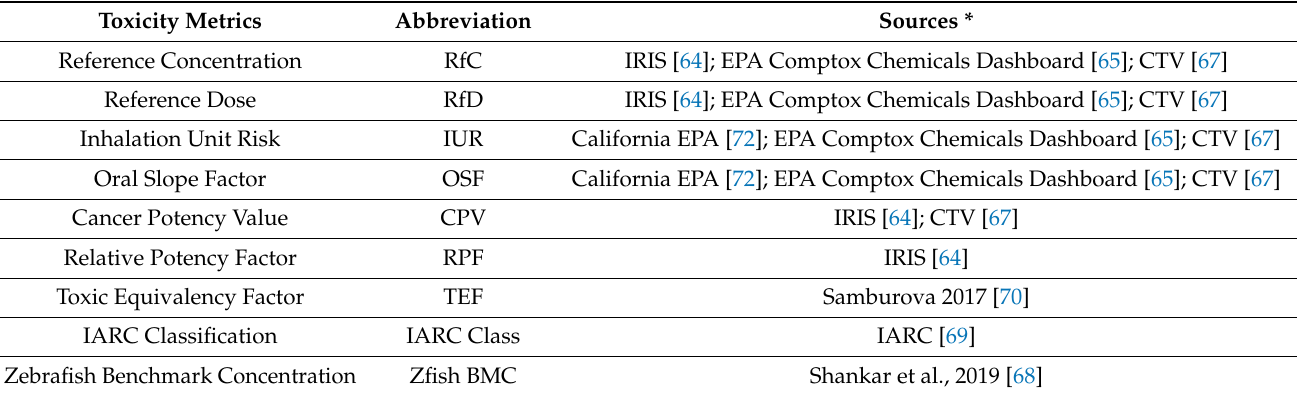
Table 1. Collected toxicity metrics, abbreviations and associated